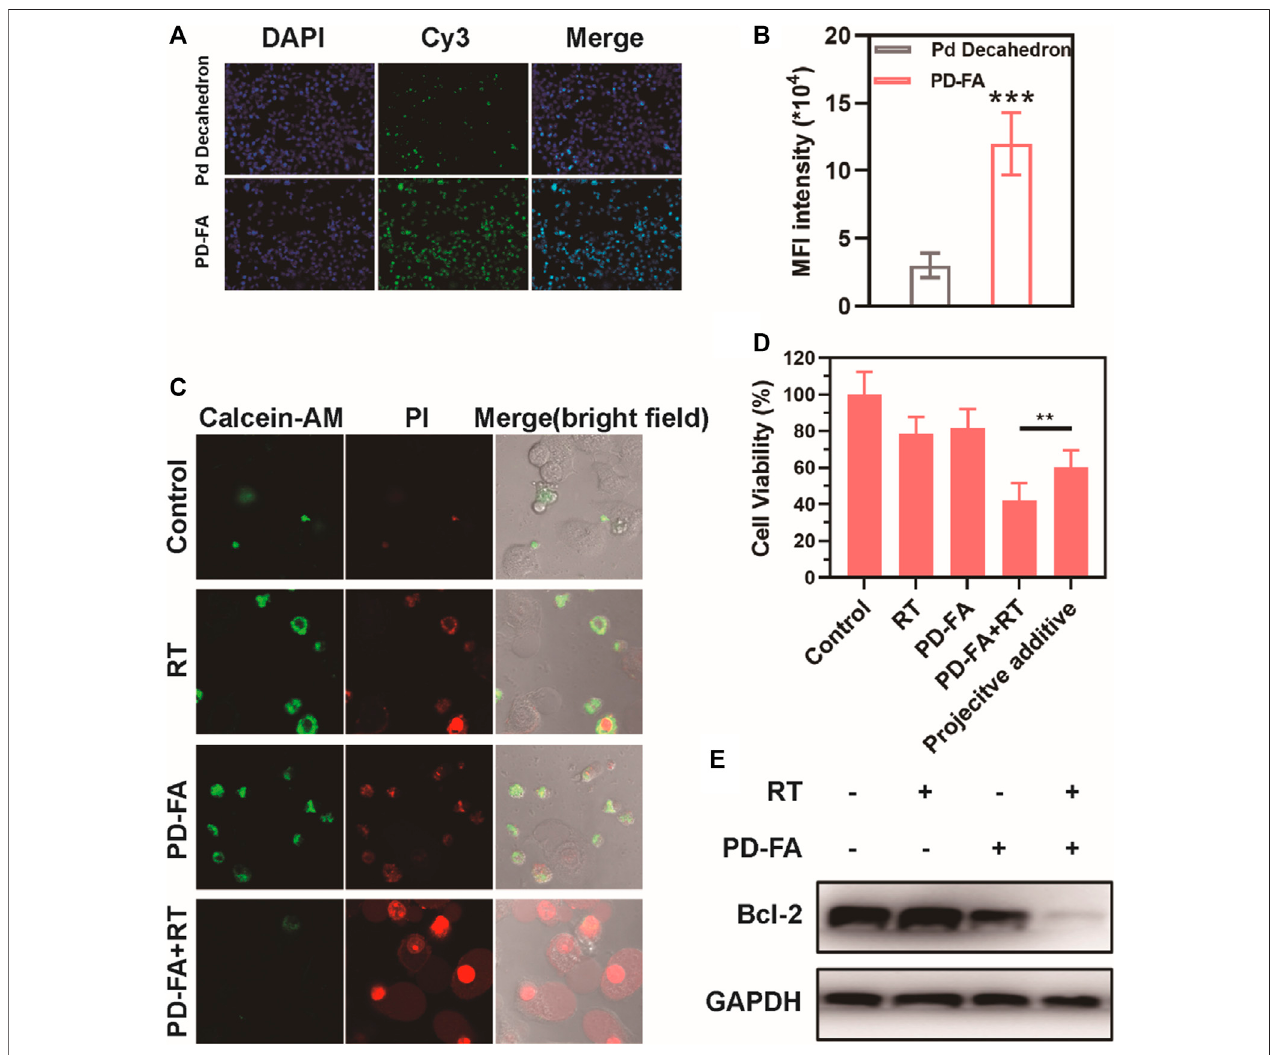
FIGURE 2 | Assessment of the in vitro radiosensitization ability of PD-FA in vitro . (A) CLSM images of cells and (B) corresponding quantitative analyses of image fl uorescence. (C) CLSM images of live and dead cells following the indicated treatments and (D) results of CCK-8 assay. (E) Western blotting results for cells in the indicated treatment